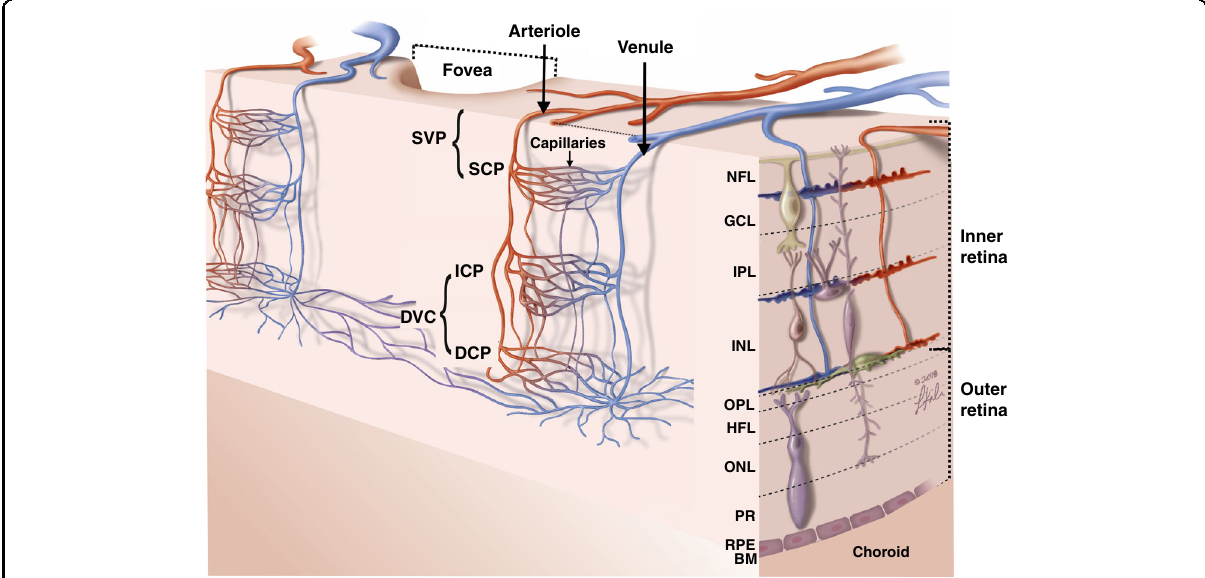
Fig. 2 Drawing of retinal circulation. Light impinges on the retina from above. SVP (super fi cial vascular plexus) comprises super fi cial arterioles and venules and SCP (super fi cial capillary plexus); DVC (deep vascular complex) includes ICP (intermediate capillary plexus) and DCP (deep capillary plexus). SCP, ICP, and DCP are thin vascular complexes that are connected to one another and receive the arteriolar supply (red) from SVP arterioles and drain (blue) to SVP venules. NFL, nerve fi ber layer; GCL, ganglion cell layer; IPL, inner plexiform layer; INL, inner nuclear layer; OPL, outer plexiform layer; HFL, Henle fi ber layer; ONL, outer nuclear layer; PR, photoreceptors; RPE, retinal pigment epithelium. The Bruch ’ s membrane (BM) is just below the RPE. The inner retina is de fi ned as the NFL to OPL, and the outer retina (which contains no vessels) as the HFL, ONL, PR, and RPE. Not shown: in the peripapillary retina (near the optic disc, not shown here but presented in Fig. 3), an additional vascular plexus is present: RPCP (radial peripapillary capillary plexus). RPCP and SVP together are commonly known as the SVC (super fi cial vascular complex). Adapted with permission from Nesper